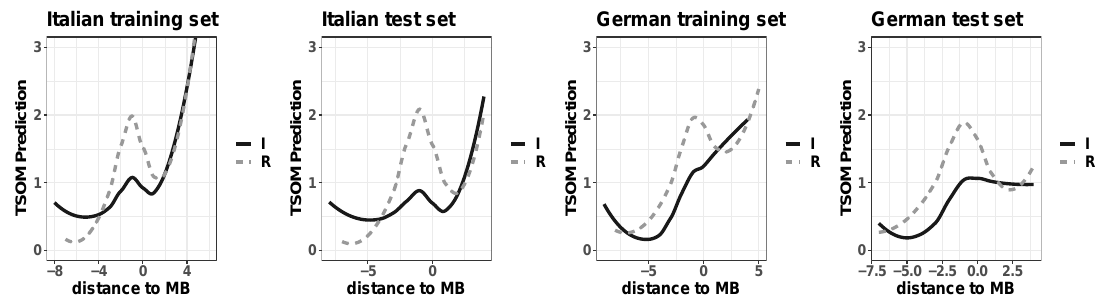
Figure 6. Regression plots of interaction between morphological (ir)regularity (Regulars versus Irregulars) and distance to morpheme boundary (MB) in non-linear models (GAMs) fitting the incremental number of correctly predicted symbols by the trained TSOMs on Italian ( left plots ) and German ( right plots ) for training and test